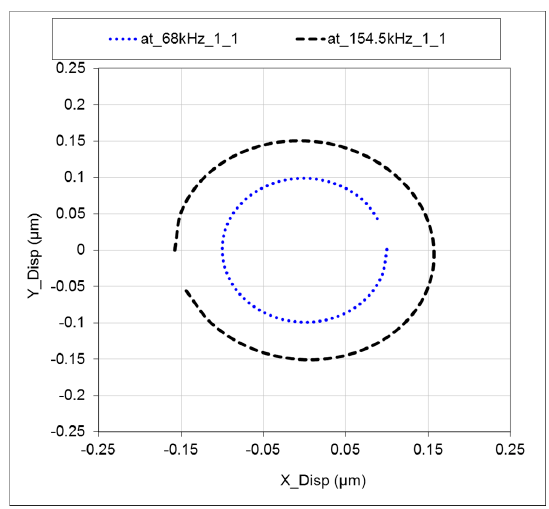
Figure 10. Calculated motion trajectories at first (68.7 kHz) and second (154.5 kHz) resonance modes.